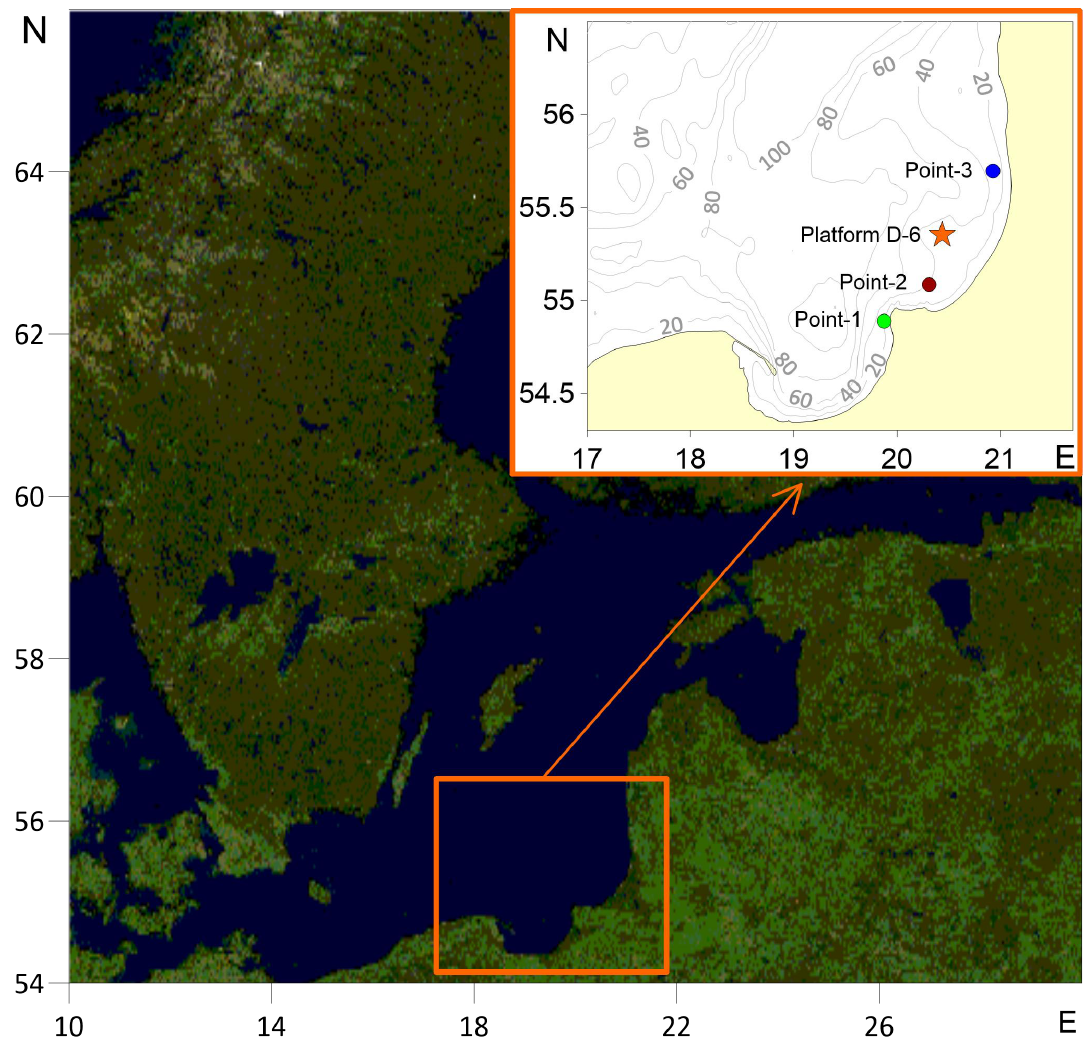
Figure 1. Study area, location of oil platform D-6 and points where upwelling criteria are calculated.